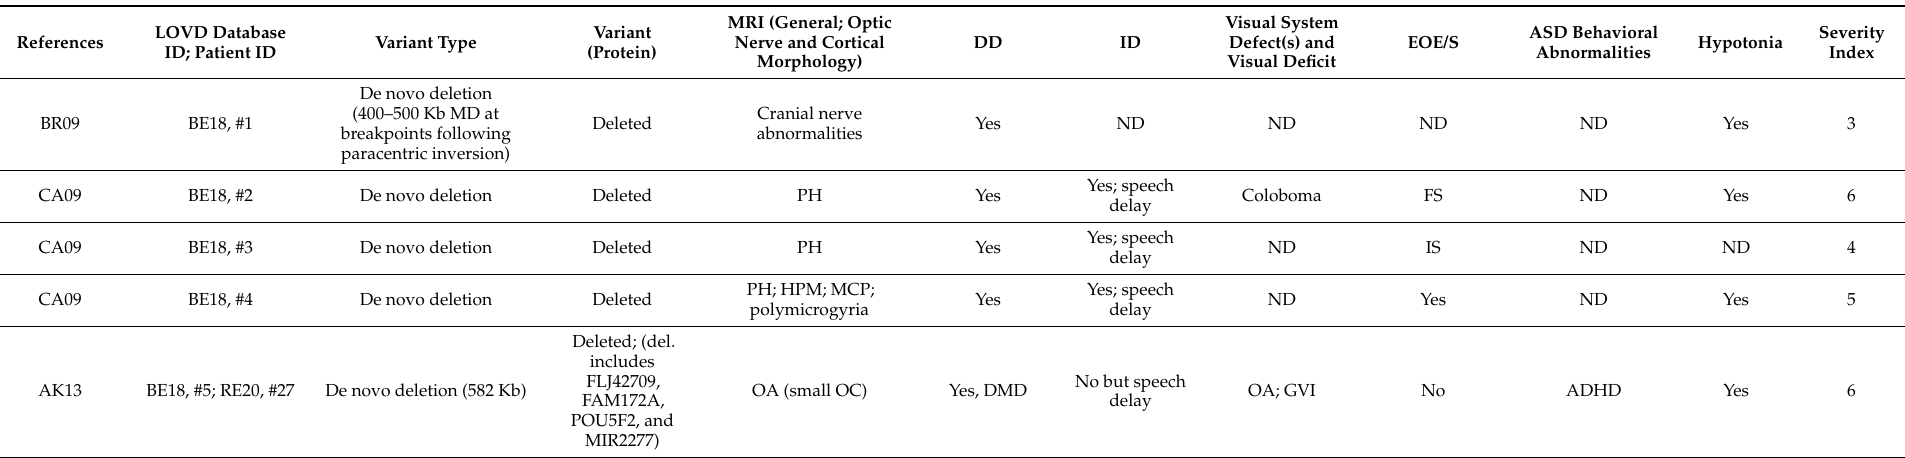
Table 1. Updated list of NR2F1 variants and clinical description of BBSOAS reported patients. BBSOAS patients, identified by their protein variant and—when available—by their LOVD identifier, are listed following the chronological order of reports and publications describing their cases. Main clinical signs include altered brain morphology as observed by MRI, developmental delay (DD), intellectual disability (ID), visual system deficits, early-onset epilepsy and seizures (EOE/S), autism spectrum disorder (ASD) and behavioral abnormalities and hypotonia. The severity index of each patient has been calculated based on the presence/absence of the main clinical signs, ranging from 1 (one symptom category only found in the patient) to a maximum of 7 (all listed clinical signs are present, to different extent, in the same patient). An extended version of these data, with additional columns describing other less common clinical features, is available in Supplementary Table S1. List of references : AK13, Al-Kateb et al., 2013; BA19, Balciuniene et al., 2019; BE18, Bertacchi et al., 2018; BE20, Bertacchi et al., 2020; BR09, Brown et al., 2009; CA09, Cardoso et al., 2009; BO14, Bosch et al., 2014; BO20, Bojanek et al., 2020; CH16, Chen et al., 2016; DI16, Dimassi et al., 2016; EL17, Eldomery et al.,